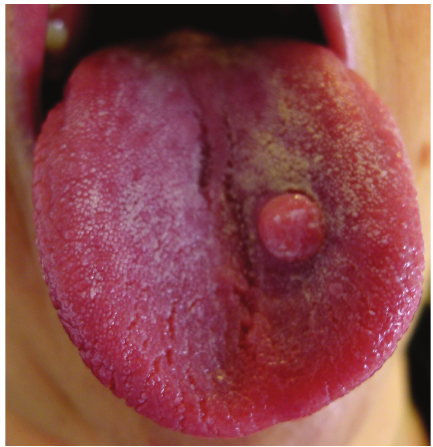
Figure 1: Intraoral photo of the granular cell tumour a ff ecting the dorsum of the tongue.